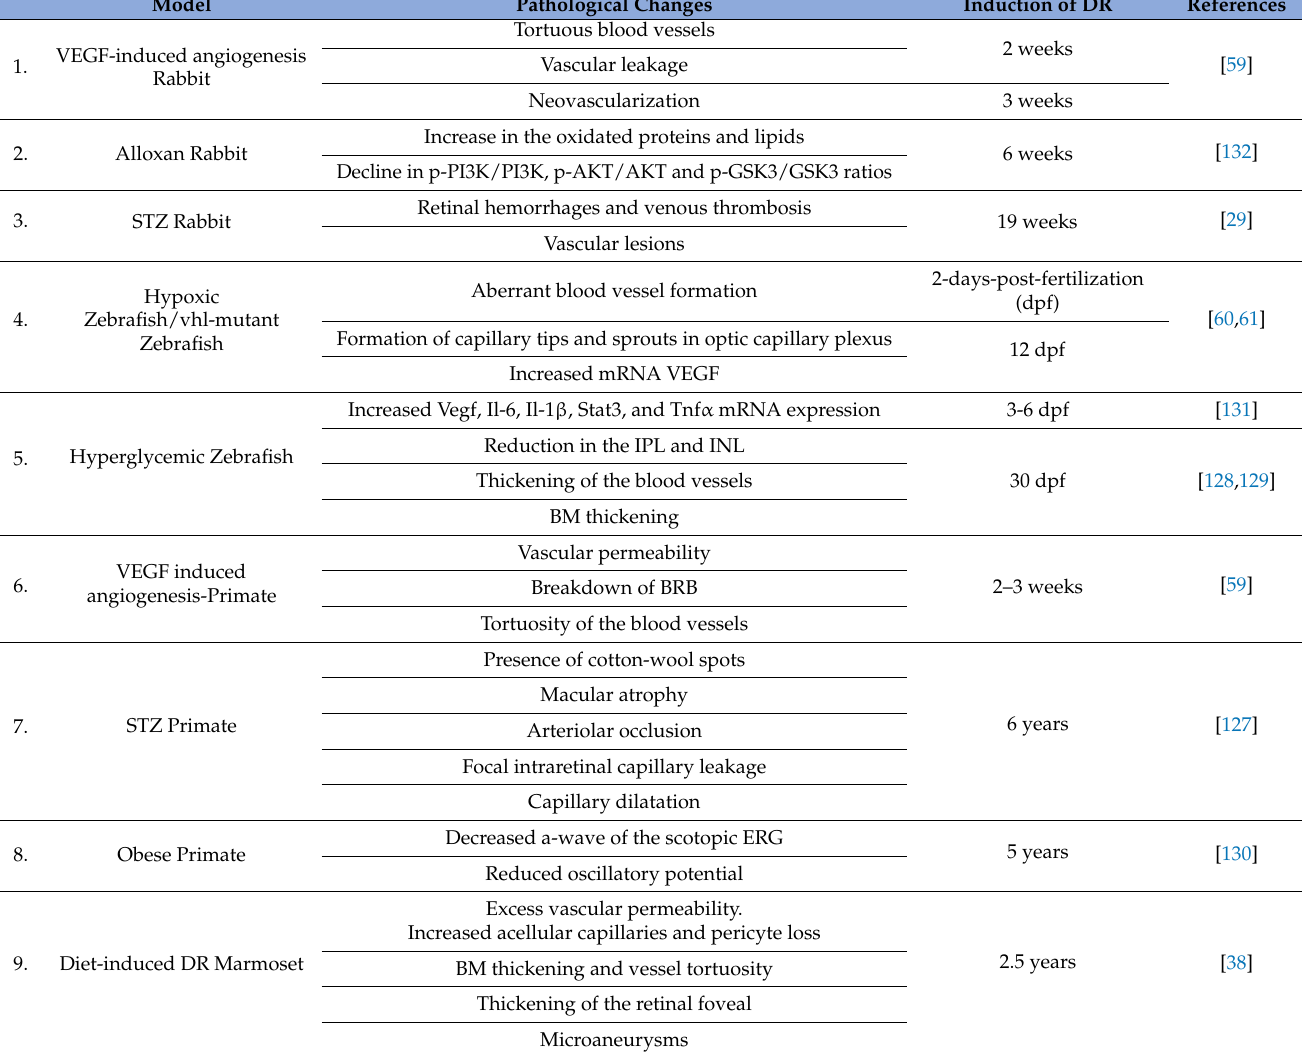
Table 3. Pathological changes in non-rodent models of diabetic